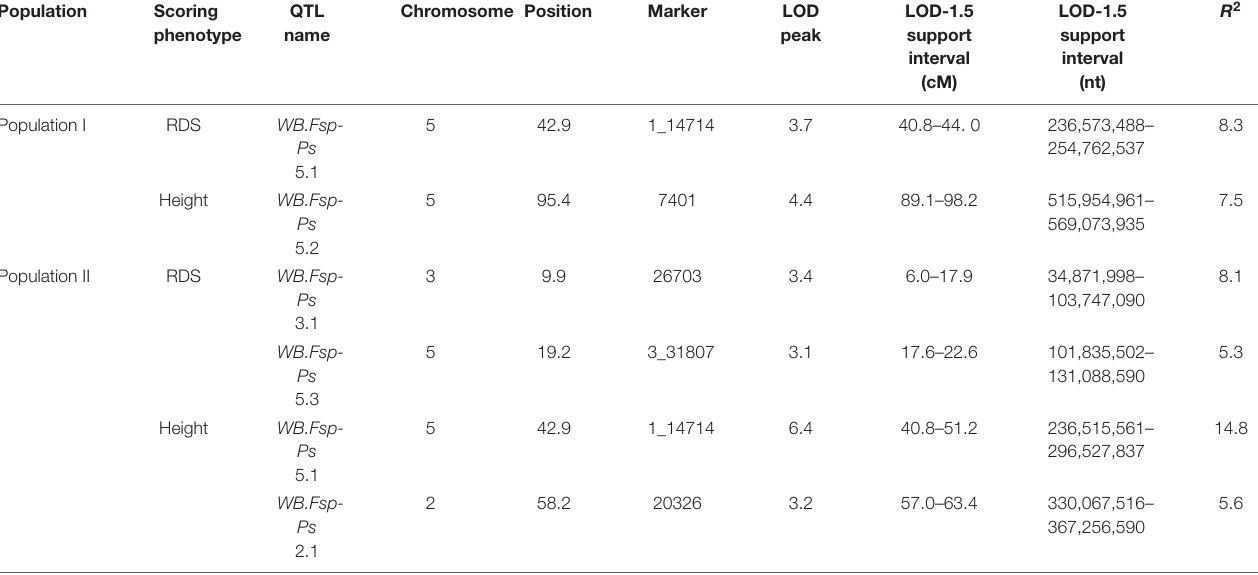
TABLE 3 | Quantitative trait loci detected for resistance to Fusarium solani f. sp. pisi root rot in two RIL populations using root disease severity (RDS) and